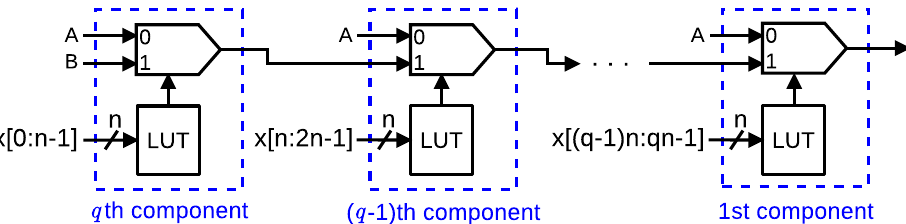
Figure 4. CFUN architecture to implement basic wide logic functions using carry